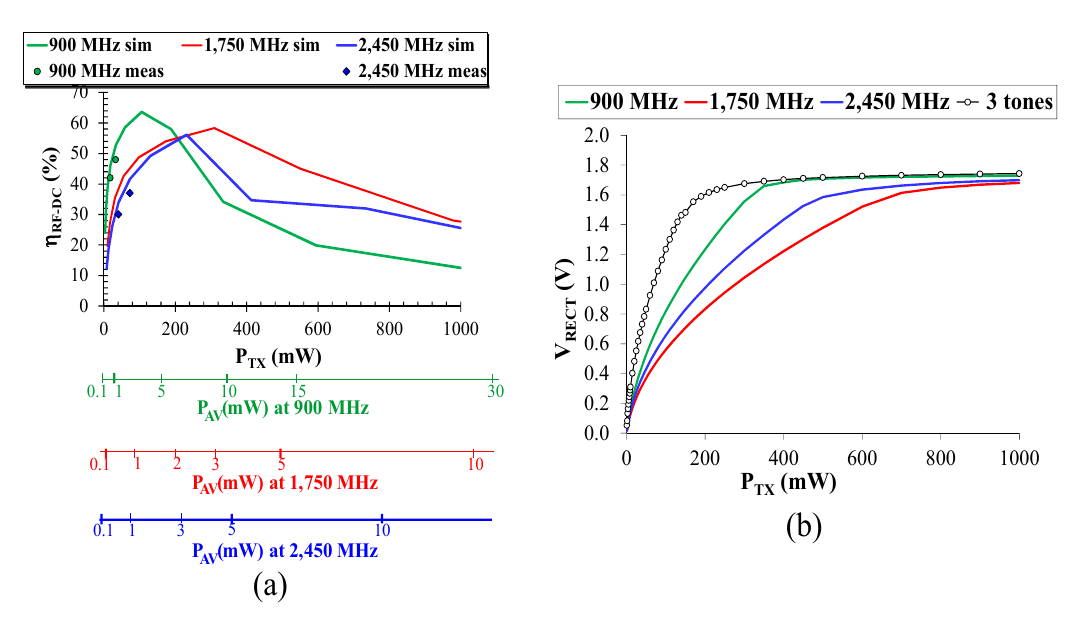
Figure 9. ( a ) Conversion efficiencies of the whole wearable rectenna at the three operating frequencies. ( b ) Rectified output voltage at the three operating frequencies and in the contemporaneous presence of the three